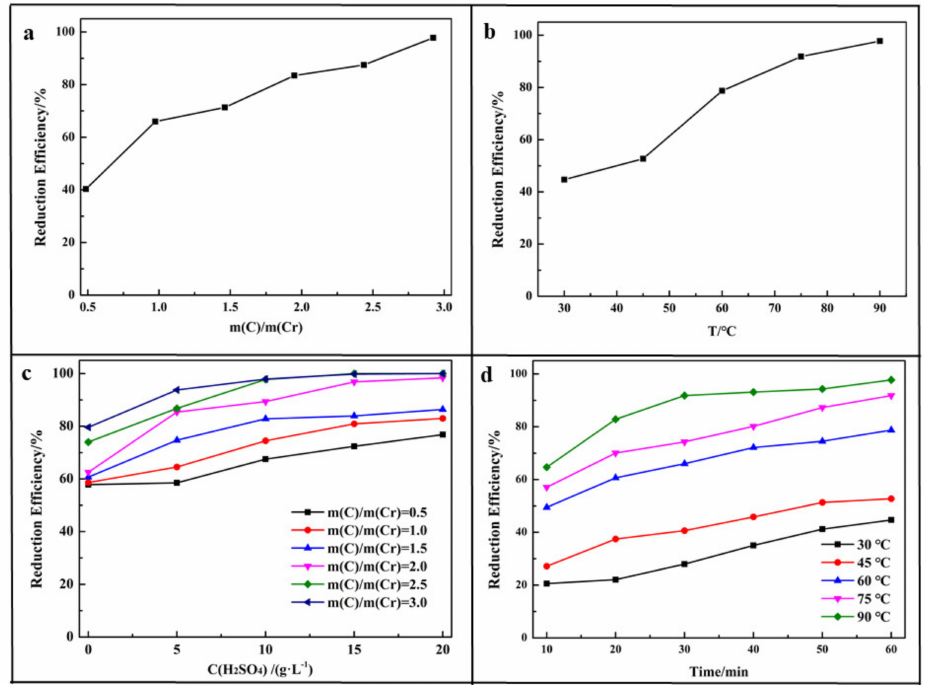
Figure 1. Effect of the single parameters on the reduction process: ( a ) Dosage of biochar (m(C)/m(Cr)); ( b ) reaction temperature; ( c ) concentration of H2SO4; ( d ) reaction